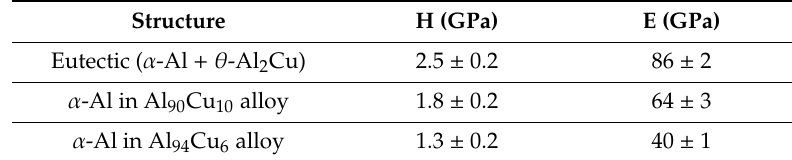
Table 2. Hardness (H) and elastic modulus (E) of different structures in alloys, measured by nano ‐ indentation.